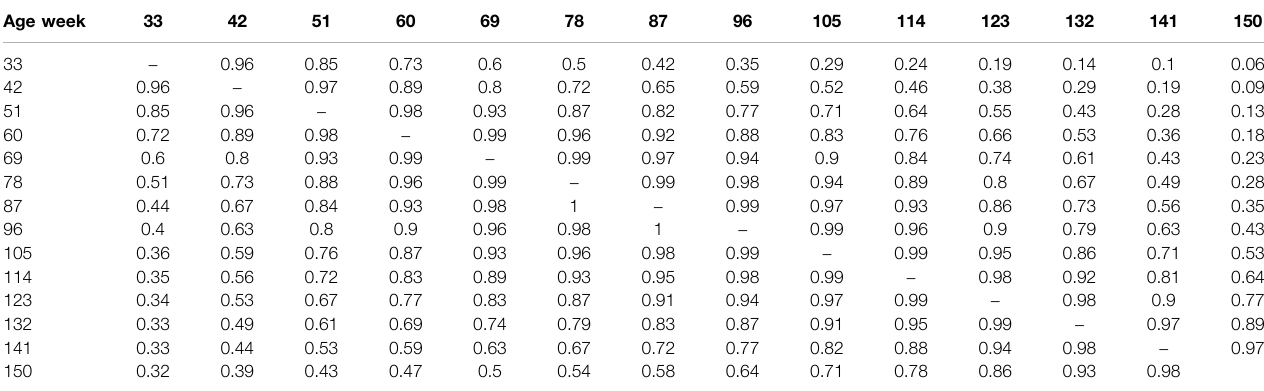
TABLE 4 | Genetic correlations between semen volume of all ages, estimated with a random regression model. Age week